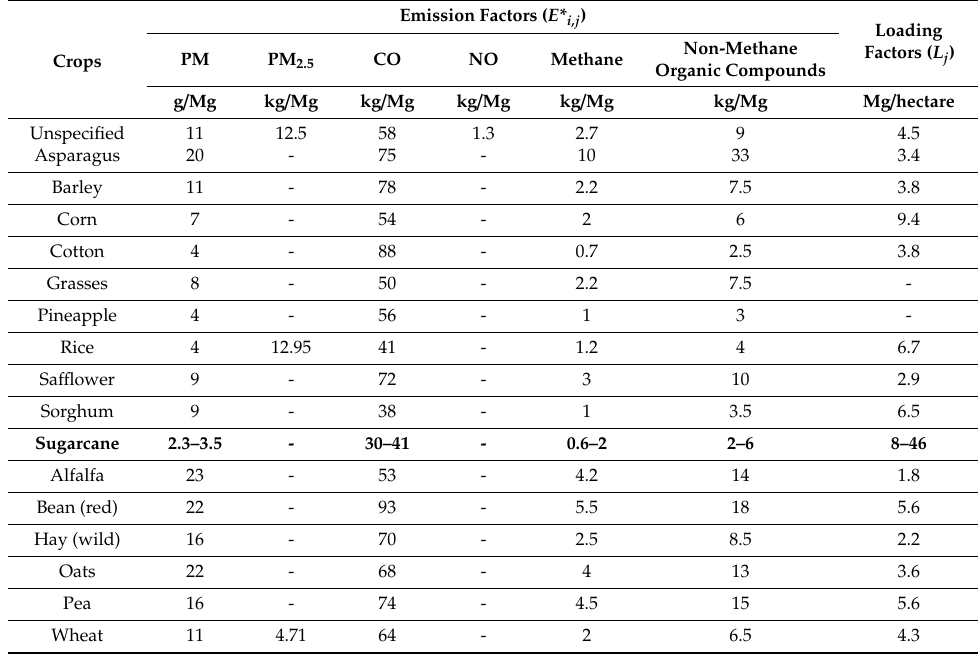
Table 1. Emission factors and loading factors for di ff erent crops